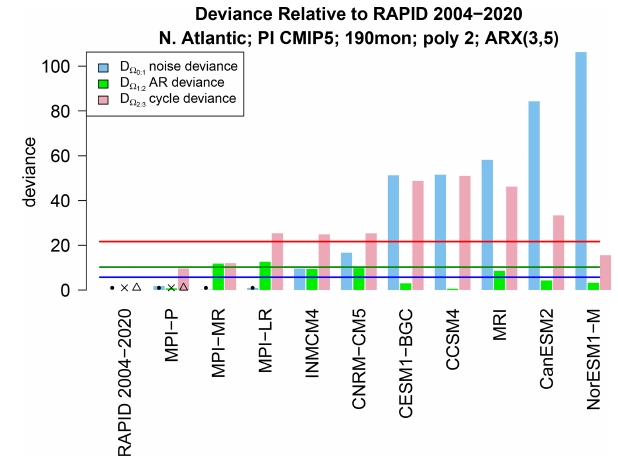
Figure 10. Ratio of noise variances between time series on the (pink bar), cycle deviance D (cid:127) Figure 9. The AR deviance D (cid:127) x axis and observations. Ratios less than one indicate that the 2 : 3 1 : 2 (green bar), and noise deviance D (cid:127) (blue bar) between fitted CMIP5 model has less noise variance than observations. The hor- 0 : 1 ARX(3,5) models. The red, green, and blue lines show the corre- izontal grey lines show the upper and lower significance thresh- sponding significance levels at the FWER of 5%. The dot, cross, olds for rejecting equality of noise variances based on a signifi- and triangle indicate insignificant deviances. Each deviance is com- cance level to control for a FWER of 5%. The noise variances are puted from pairs of time series each of length 190 months. each derived by fitting ARX(3,5) models to time series of length 190 months.